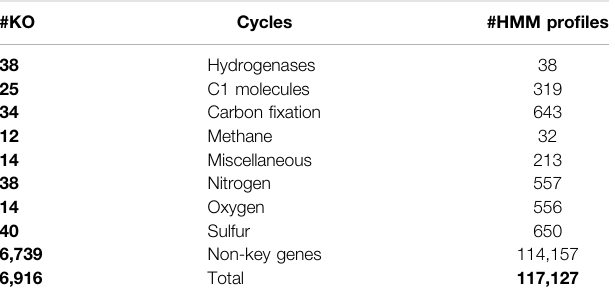
TABLE 3 | Number of genes per subset (cycle) and the number of corresponding HMM pro fi les.